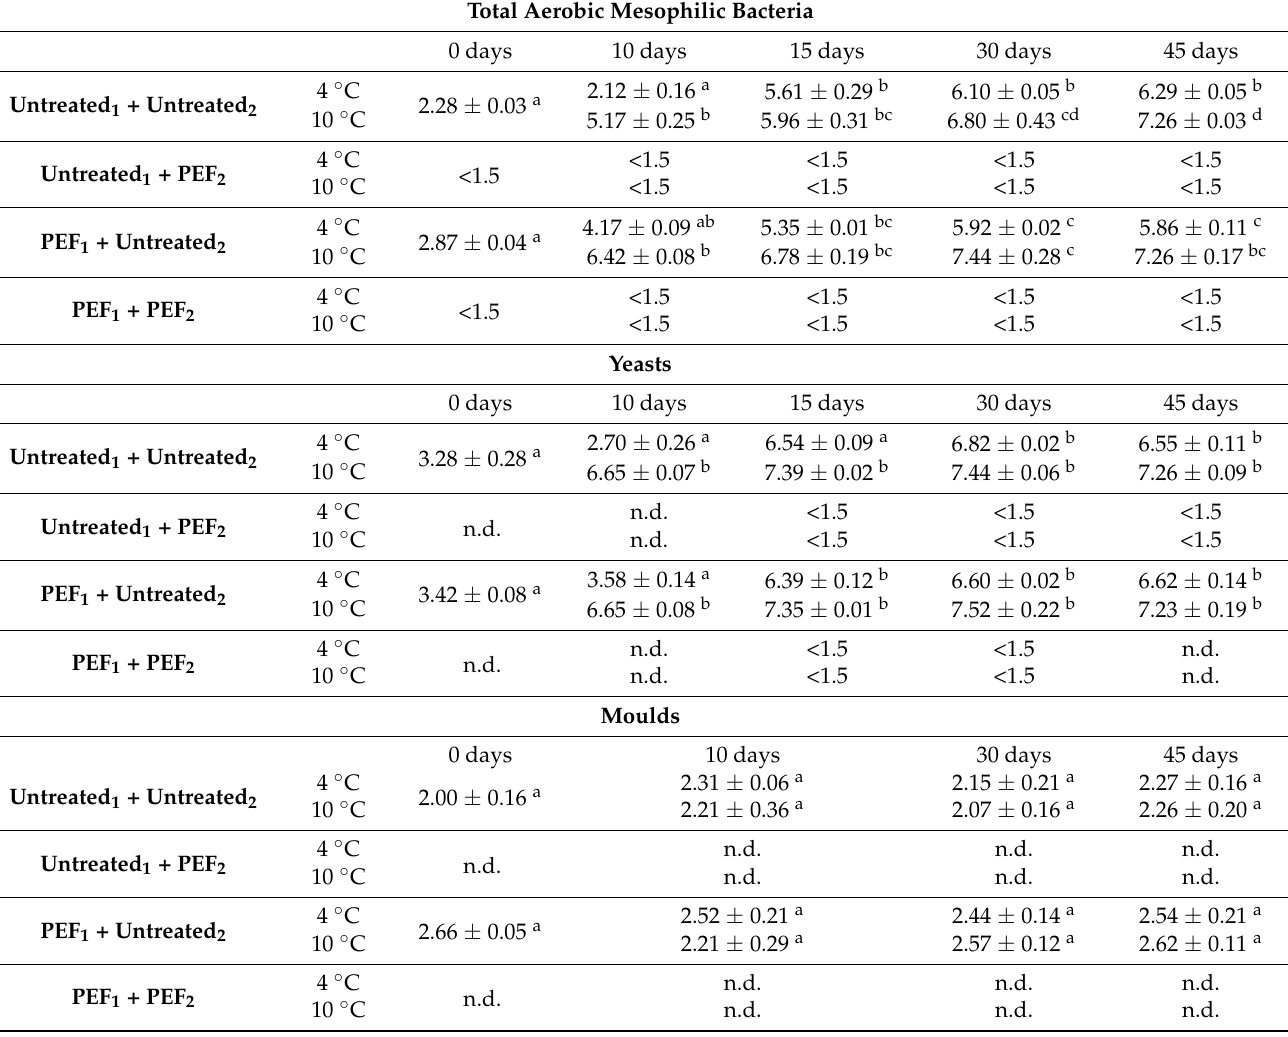
Table 3. Change of microbial population (Log 10 CFU/mL) along storage time in juice from untreated grapes without decontamination by PEF (Untreated 1 + Untreated 2 ), juice from untreated grapes decontaminated by PEF (Untreated 1 + PEF 2 ), juice from PEF-treated grapes without decontamination by PEF (PEF1 + Untreated 2 ), and juice from PEF-treated grapes decontaminated by PEF (PEF 1 + PEF 2 ). Total Aerobic Mesophilic